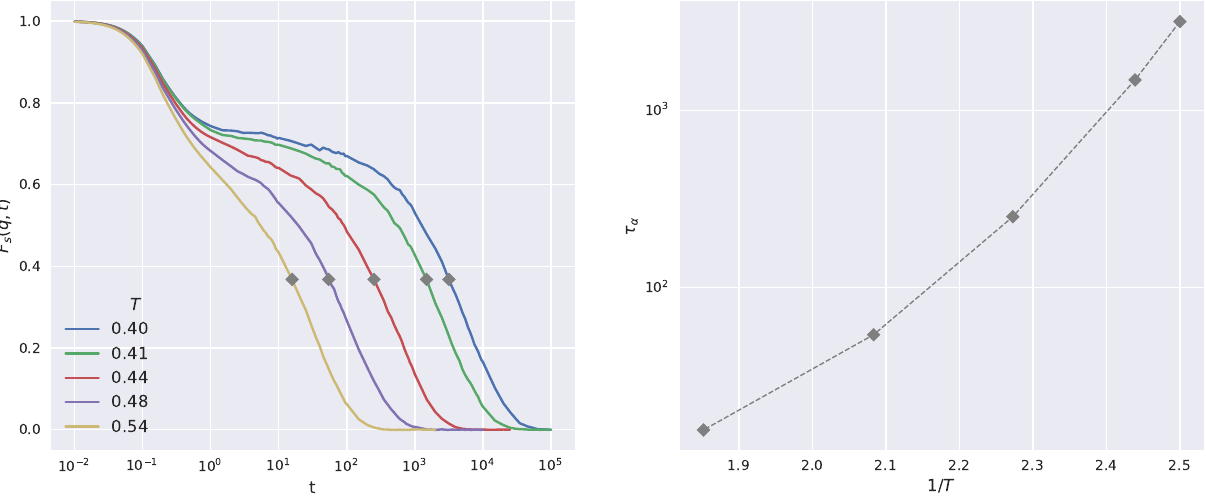
Figure 1. ( Left ): Temperature dependence of ISF. Dots mark the position of the structural relaxation time τ α . ( Right ): Arrhenius plot of the structural relaxation time τ α . Within ICE it is common practice to characterize the dynamics of the particles in terms of the propensity ∆ r i ( t ) , the displacement of the i -th particle in a time t starting from a fixed initial configuration and averaged within a single ICE. Figure 2 plots the temperature dependence of the average propensity (cid:104) ∆ r ( t ) (cid:105) ic , where the average (cid:104) . . . (cid:105) ic is taken over all the ICEs and all the particles (left panel), and the probability distribution of the propensity at t = τ α for all the investigated temperatures (right panel).